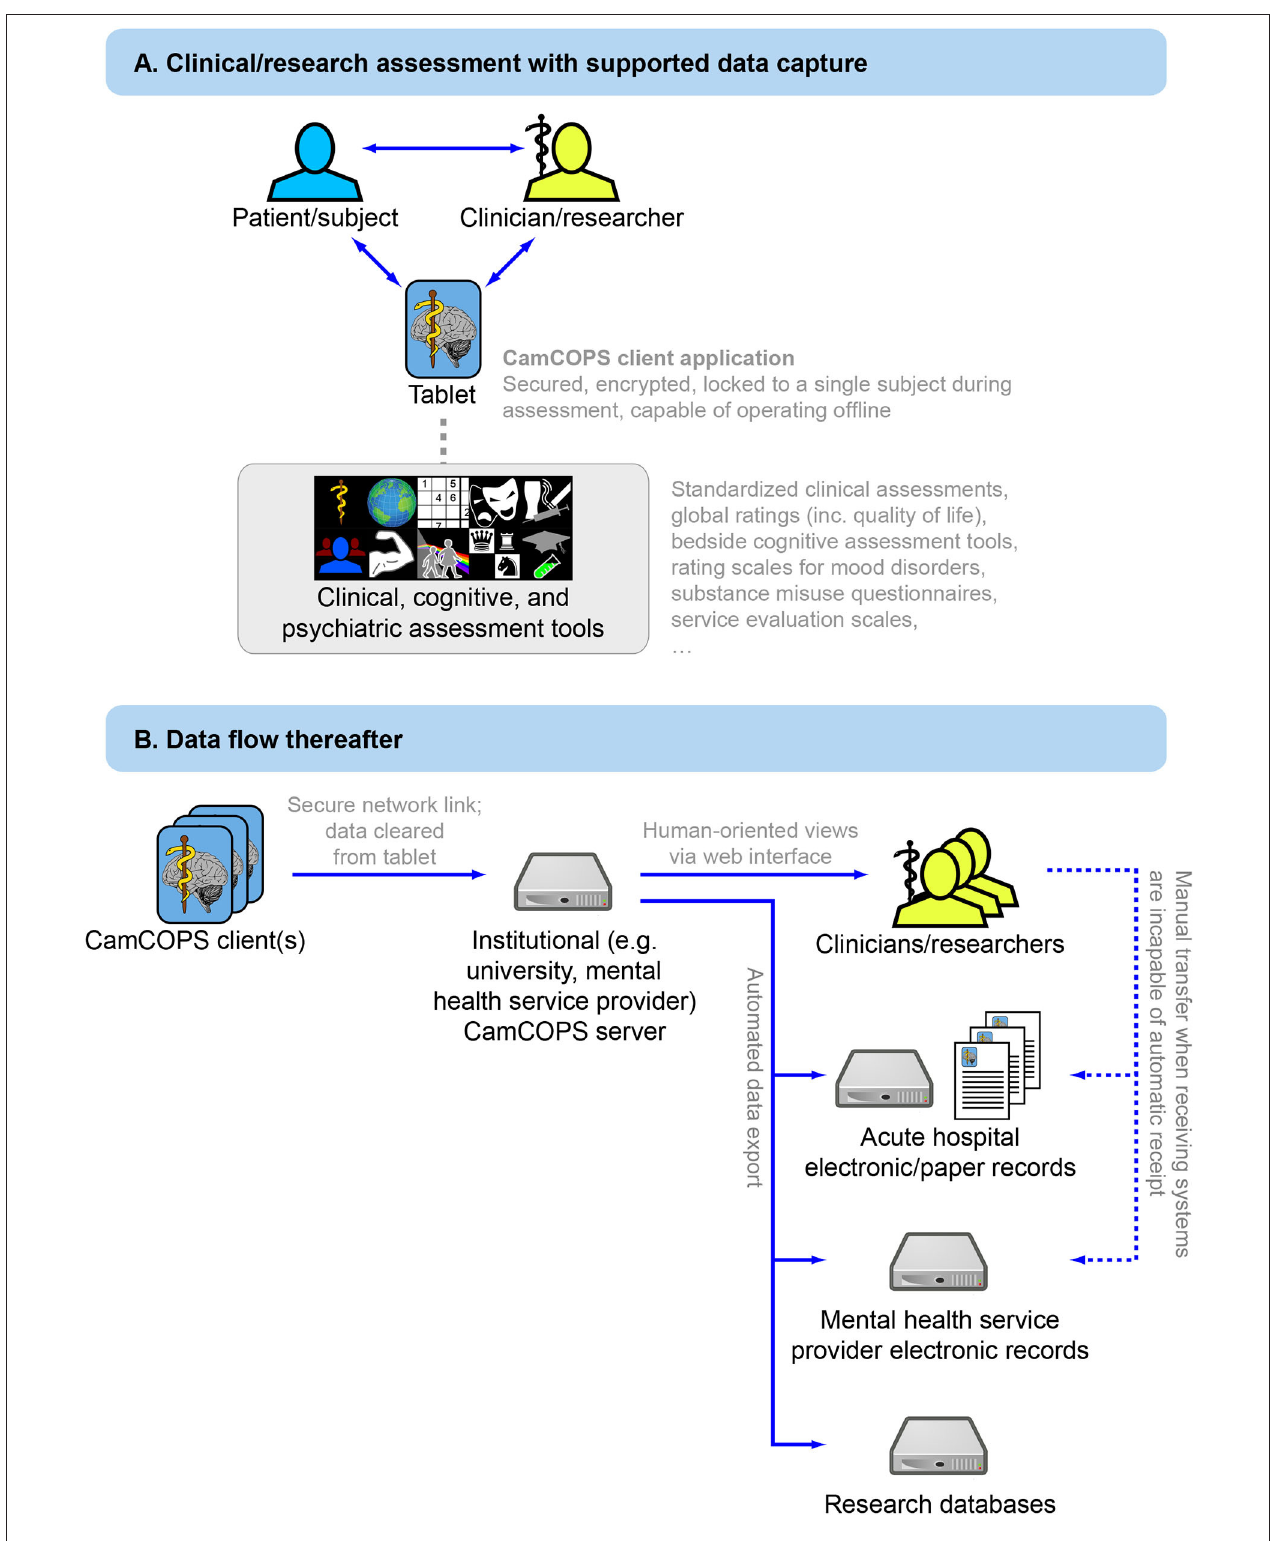
FIGURE 1 | Overview of the CamCOPS data capture system. (A) Data capture to the mobile app. (B) Subsequent data flow from the mobile device to the institution’s CamCOPS server, and thence to individuals viewing or analysing the data, and/or electronic and (if required) paper clinical records.